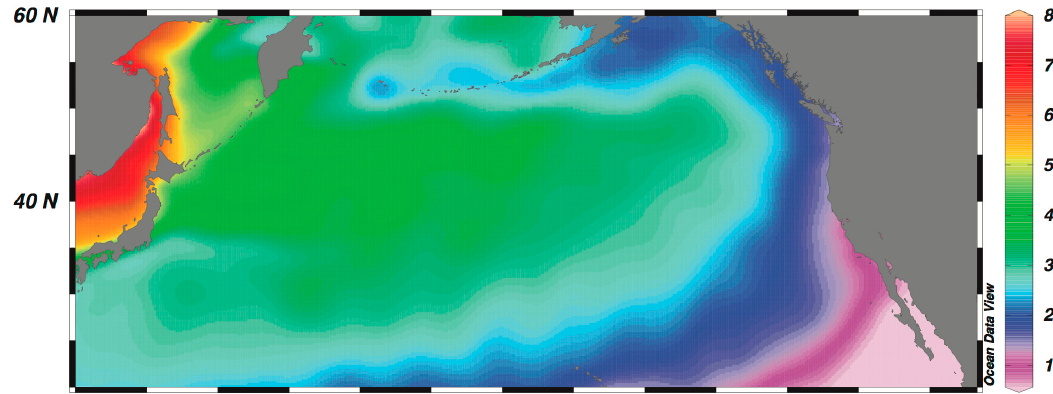
Figure 3. Ventilation characteristics of North Pacific mid-depth water masses, as evidenced by oxygen concentration in mL/L on density surface 26.8 kg/m 3 . Note the source of well-ventilated North Pacific Intermediate Water (NPIW) in the Okhotsk Sea due to brine rejection-induced ventilation processes during the wintertime sea ice season. Data from World Ocean Atlas 2009 [24]. This section may be divided by subheadings. It should provide a concise and precise description of the experimental results, their interpretation, as well as the experimental conclusions that can be drawn.